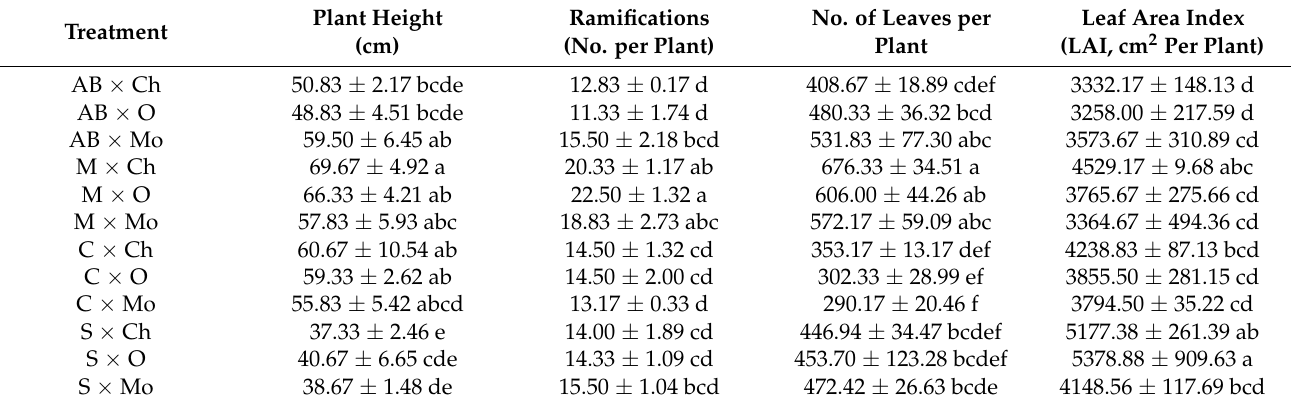
Table 4. Interaction between cultivar and fertilization type on the biometric